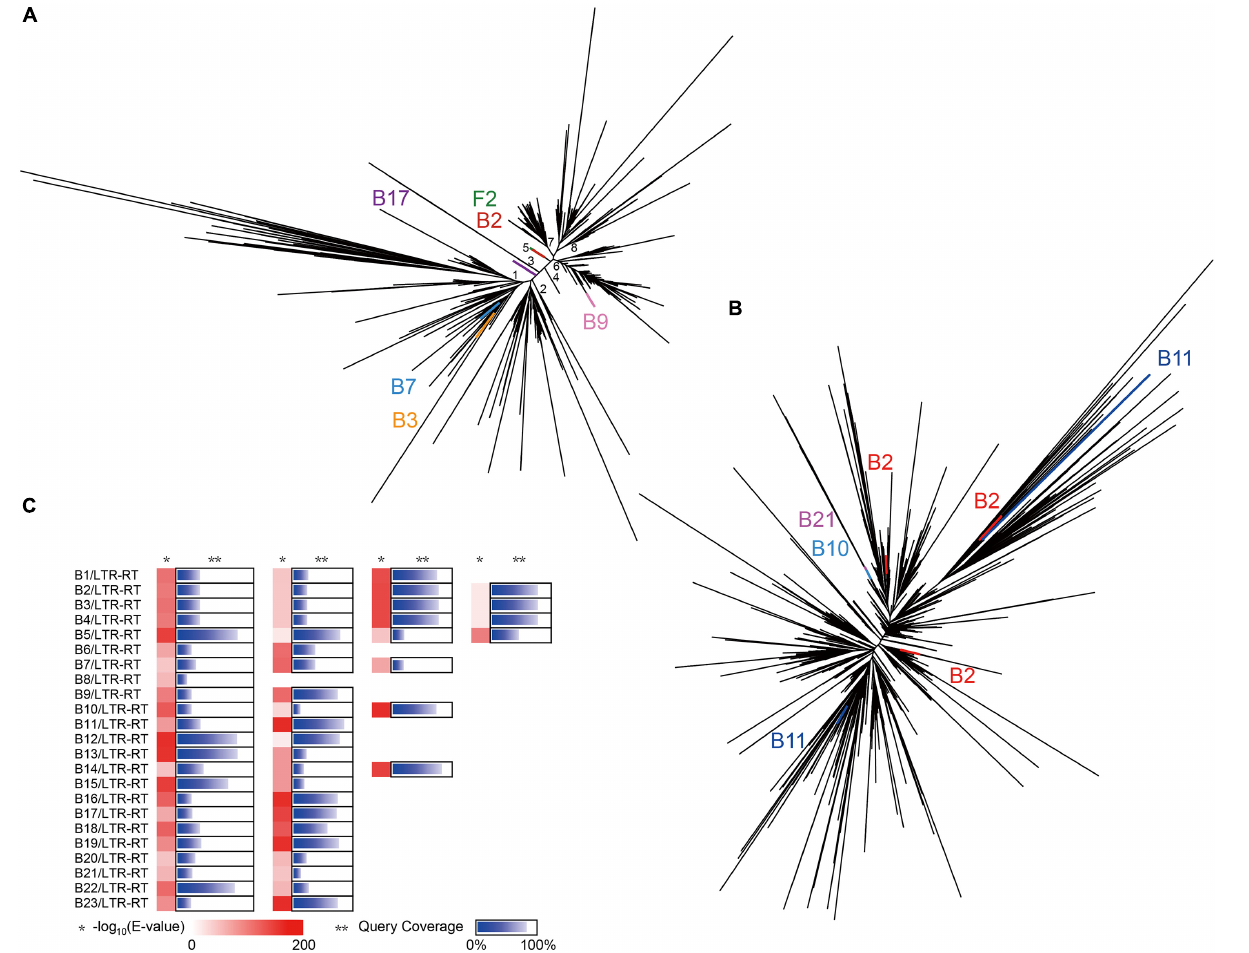
FIGURE 5 | Evolution of LTR-RTs in all isolates and Ginkgo . (A) The phylogenetic tree of the Ty3/Gypsy superfamily predicted in all isolates and Ginkgo. The lines of the same color indicated the same endogenous strain, and the black lines indicated the sequences of the Ginkgo host. (B) The phylogenetic tree of the Ty1/Copia superfamily predicted in all isolates and Ginkgo. (C) The BLASTN output of CDSs predicted in all LTRs in isolates against the Ginkgo CDSs. The shade of red rectangles means the magnitude of the E -value, and the length of the blue bar indicates the coverage of the query sequence of CDSs predicted in all LTRs in isolates. Multiple cases in each row represent multiple LTR-RTs of the same endophyte.